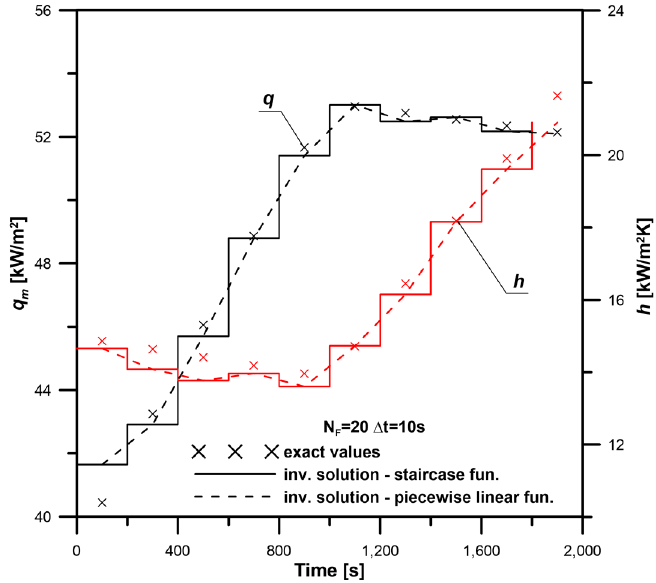
Figure 13. Comparison between exact and identified boundary conditions based on “noisy measured data”.